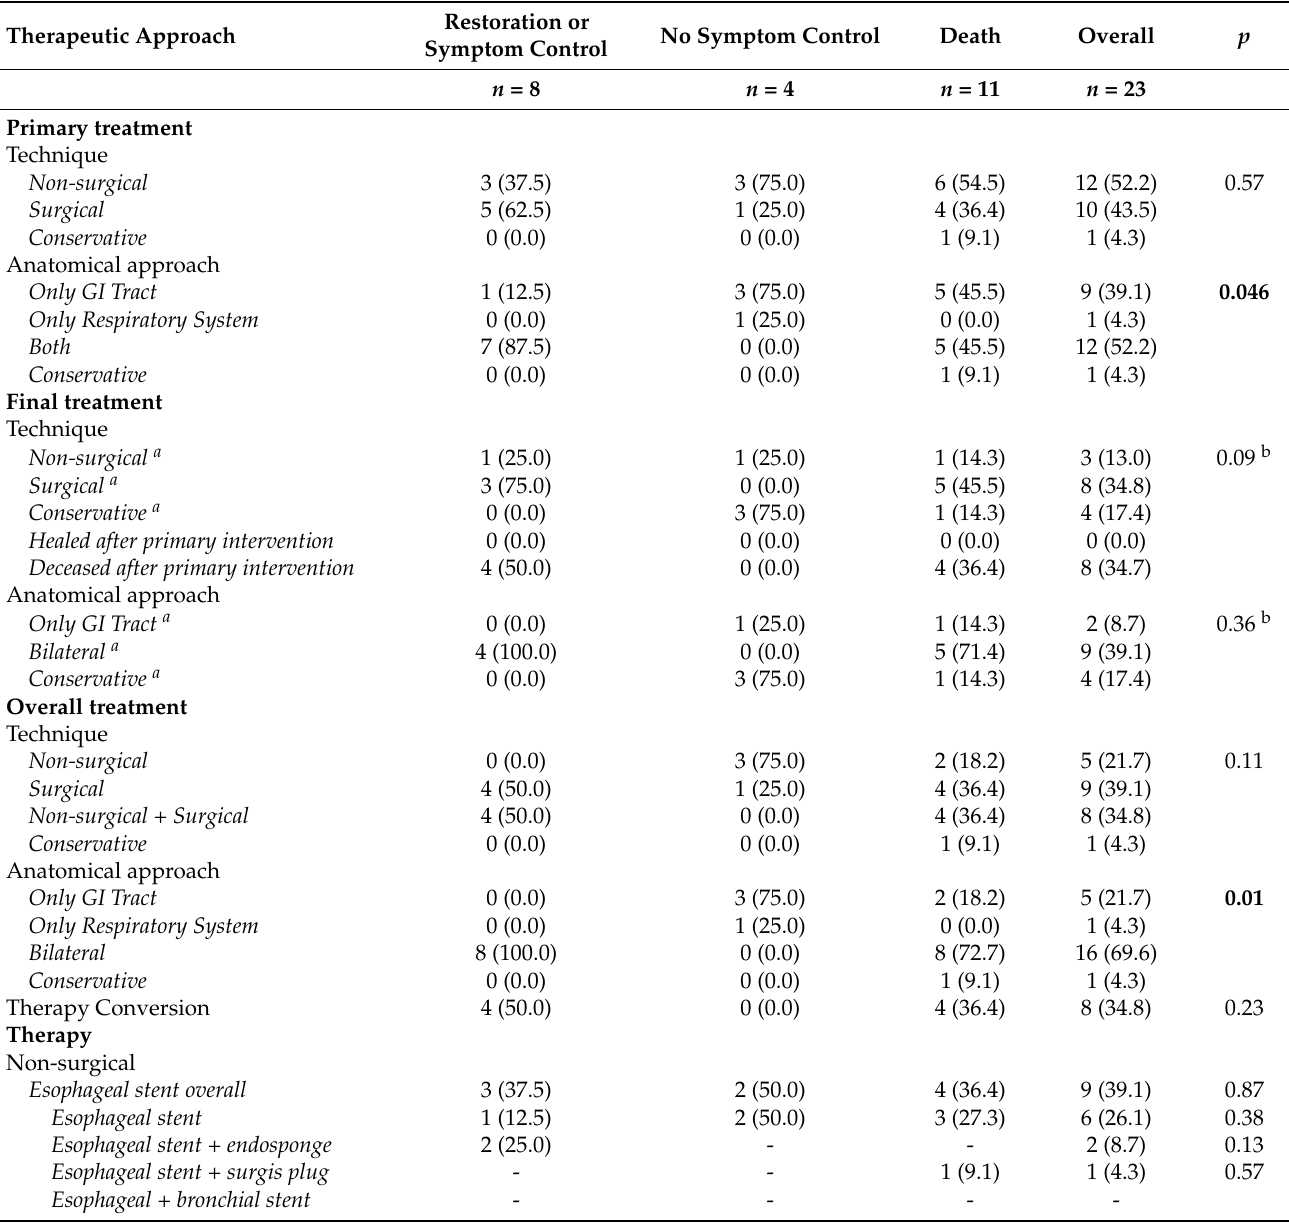
Table 5. Therapeutic management and clinical outcome of